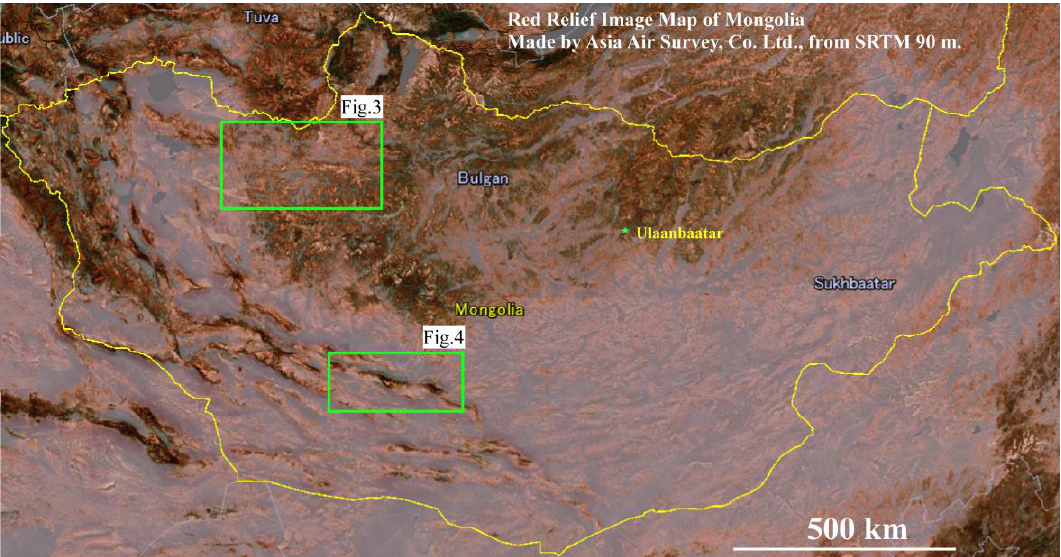
Figure 2. Topography of Mongolia. Created by SRTM3, 90m mesh digital elevation data (NASA), border line is from Google Earth).